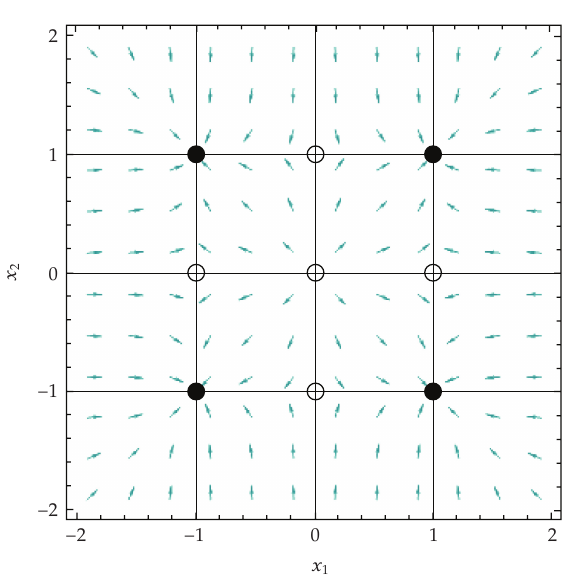
Figure 4: Phase portrait of a two-dimensional system with r (cid:8) (cid:6) 1 , 1 (cid:7) T . The stable fixed-points are represented by filled circles and the unstable ones by empty